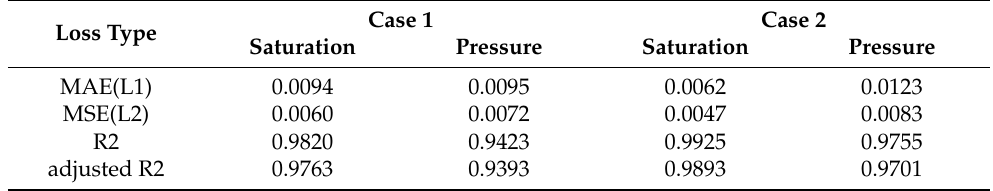
Table 3. Error values from the four types of measurements for the last predicted steps.